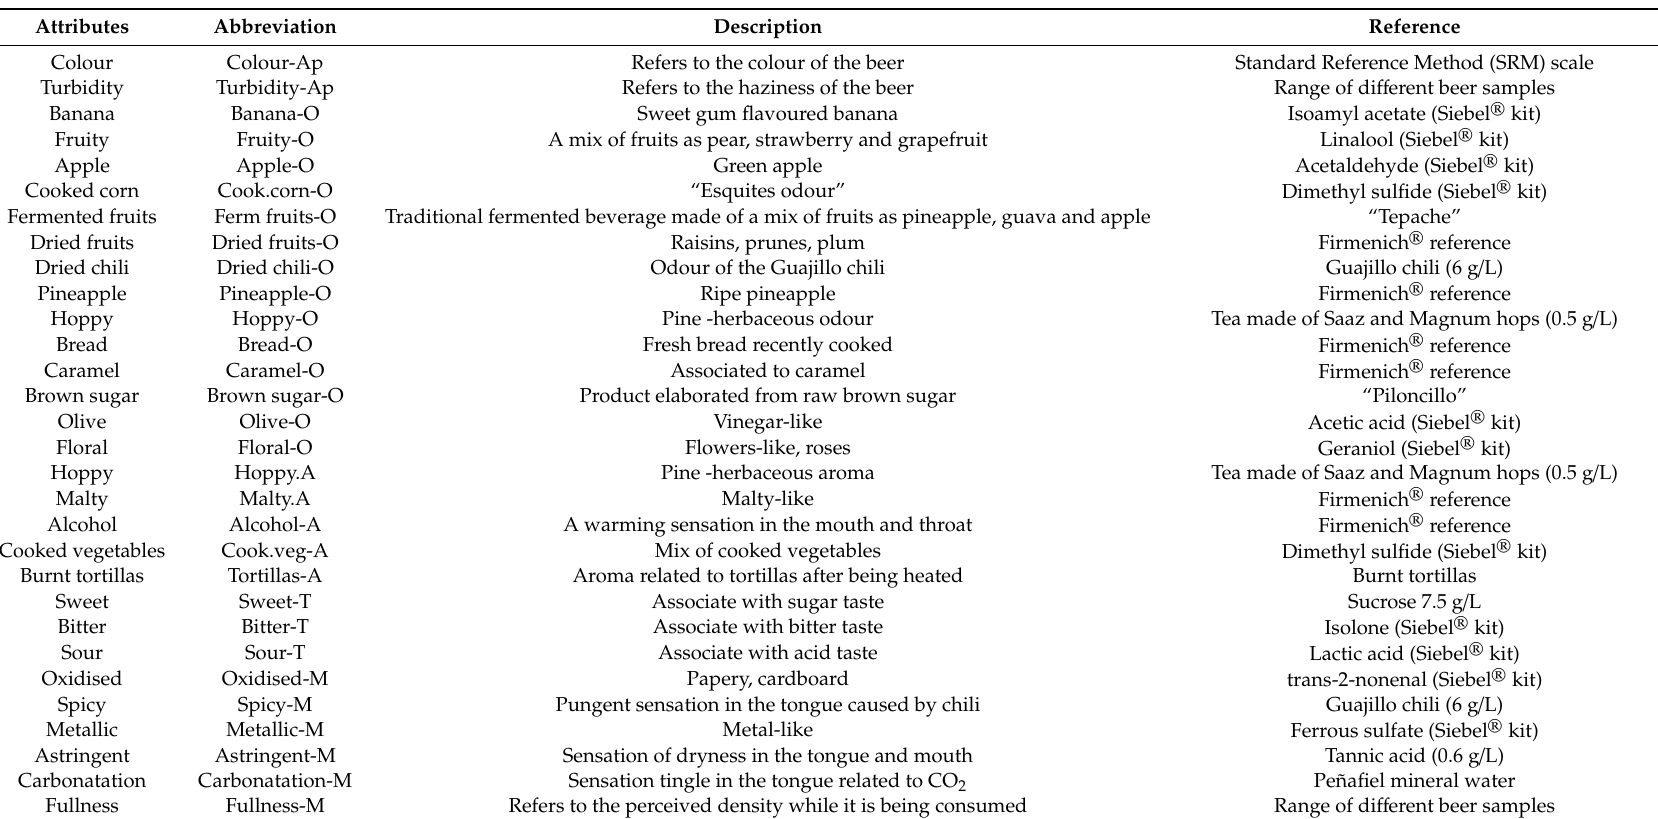
Table 3. Sensory attributes, description and physical references used in this study (attributes pertaining to appearance, odour, aroma, taste and mouthfeel are designated by an “Ap”, “O”, “A”, “T”, “M” respectively after the